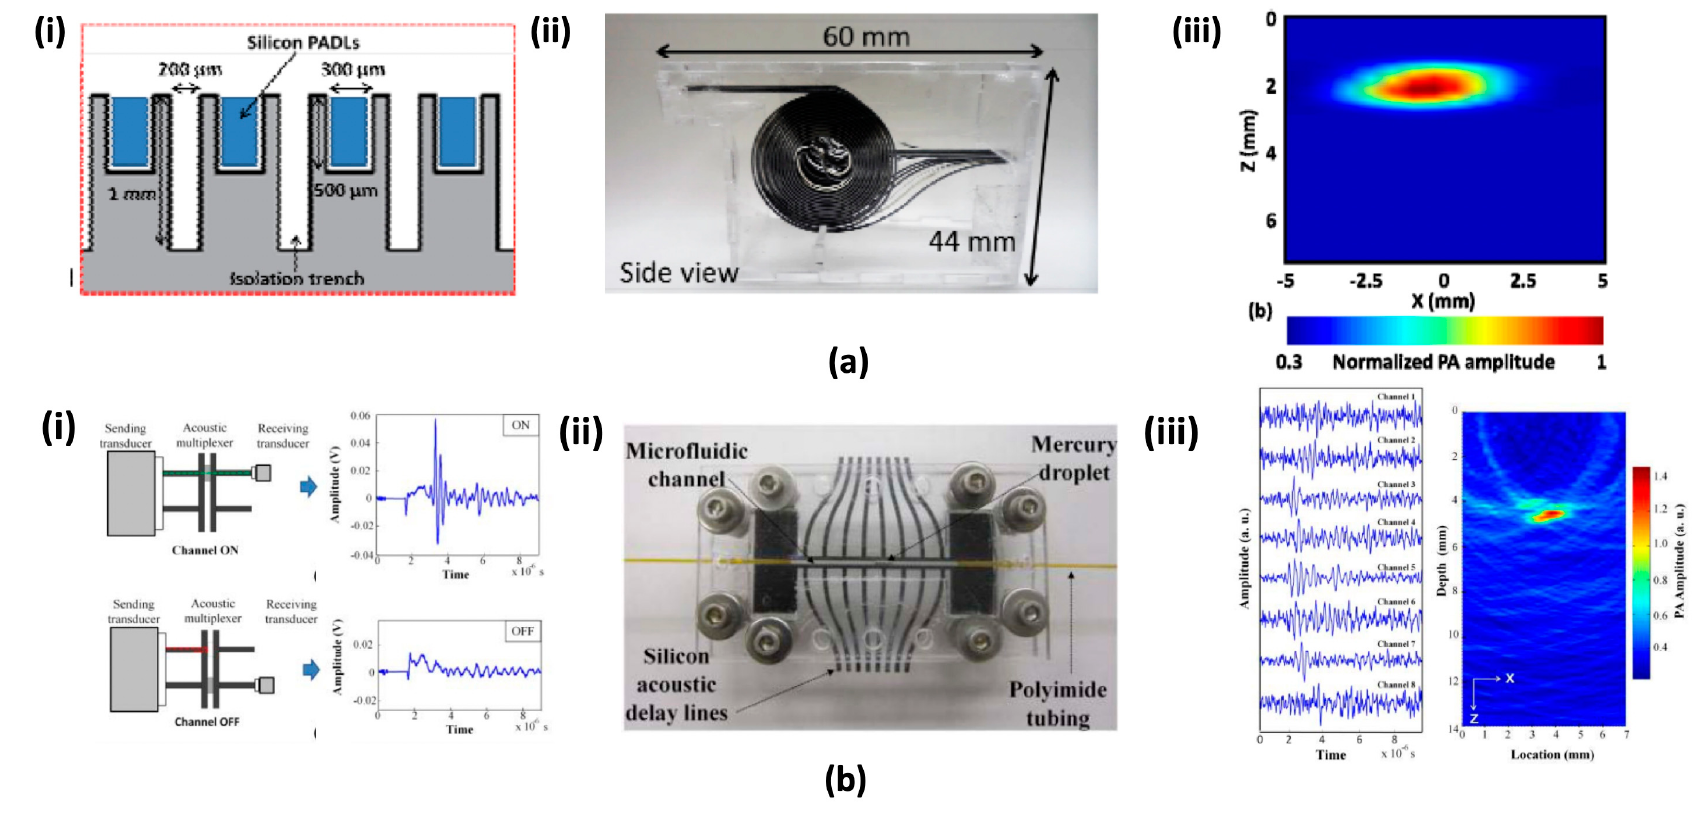
Figure 7. ( a ) Micromachined parallel silicon delay lines. ( ai ) An enlarged view of spacers with detail dimension. ( aii ) Fabricated 16 channels parallel delay lines and assembled on an acrylic housing. ( aiii ) Reconstructed two-dimensional PA image of the absorber in the phantom with 16-channel parallel delay lines [112]. Reproduced with permission from Cho, Young, et al., a micromachined silicon parallel acoustic delay line (PADL) array for real-time photoacoustic tomography (PAT); published by SPIE, 2015. ( b ) Micromachined acoustic multiplexer ( bi ) Acoustic ON/OFF characterization. ( bii ) An assembled acoustic multiplexer ( biii ) Photoacoustic signal and reconstructed image [113]. Reproduced with permission from Chang, Cheng-Chung, et al., a micromachined acoustic multiplexer for ultrasound and photoacoustic imaging applications; published by IEEE, 2014.